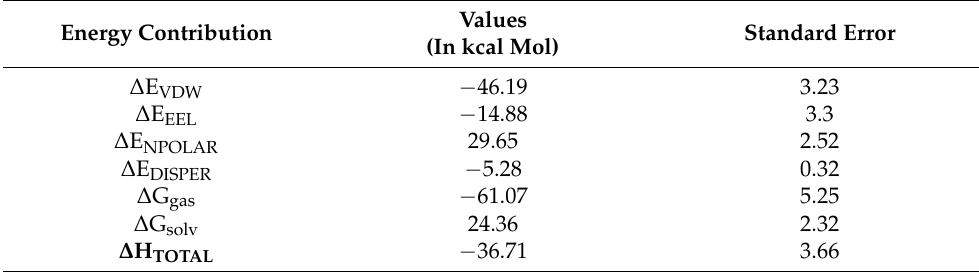
Table 2. Energy contribution when GP120 binds with NBD in Asn425Gly Mutant. All abbreviations have the same meaning as defined in Table